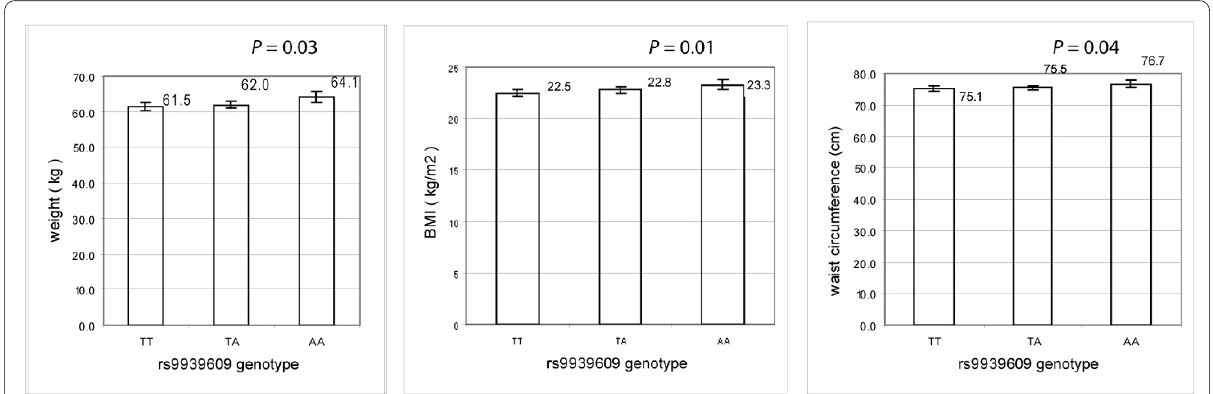
Figure 1 Association between rs9939609 and weight, BMI and waist circumference . (1) Weight, BMI and waist circumference were presented as geometric mean and 95%CI adjusted for age, ethnicity, gender and cohort; (2) P values represent significance of the additive model, adjusted for age, gender, ethnicity and cohort identifier.